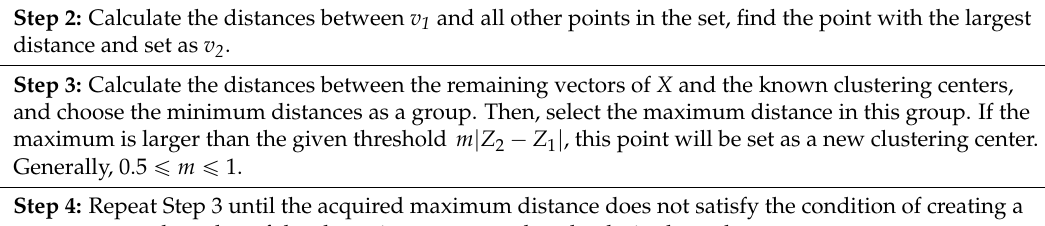
Table 2. Procedure of the maximin-distance algorithm.